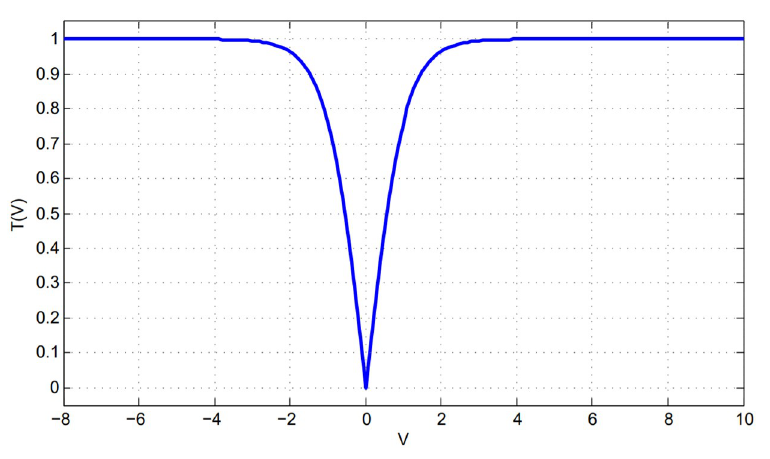
Fig 3. V-shaped transfer